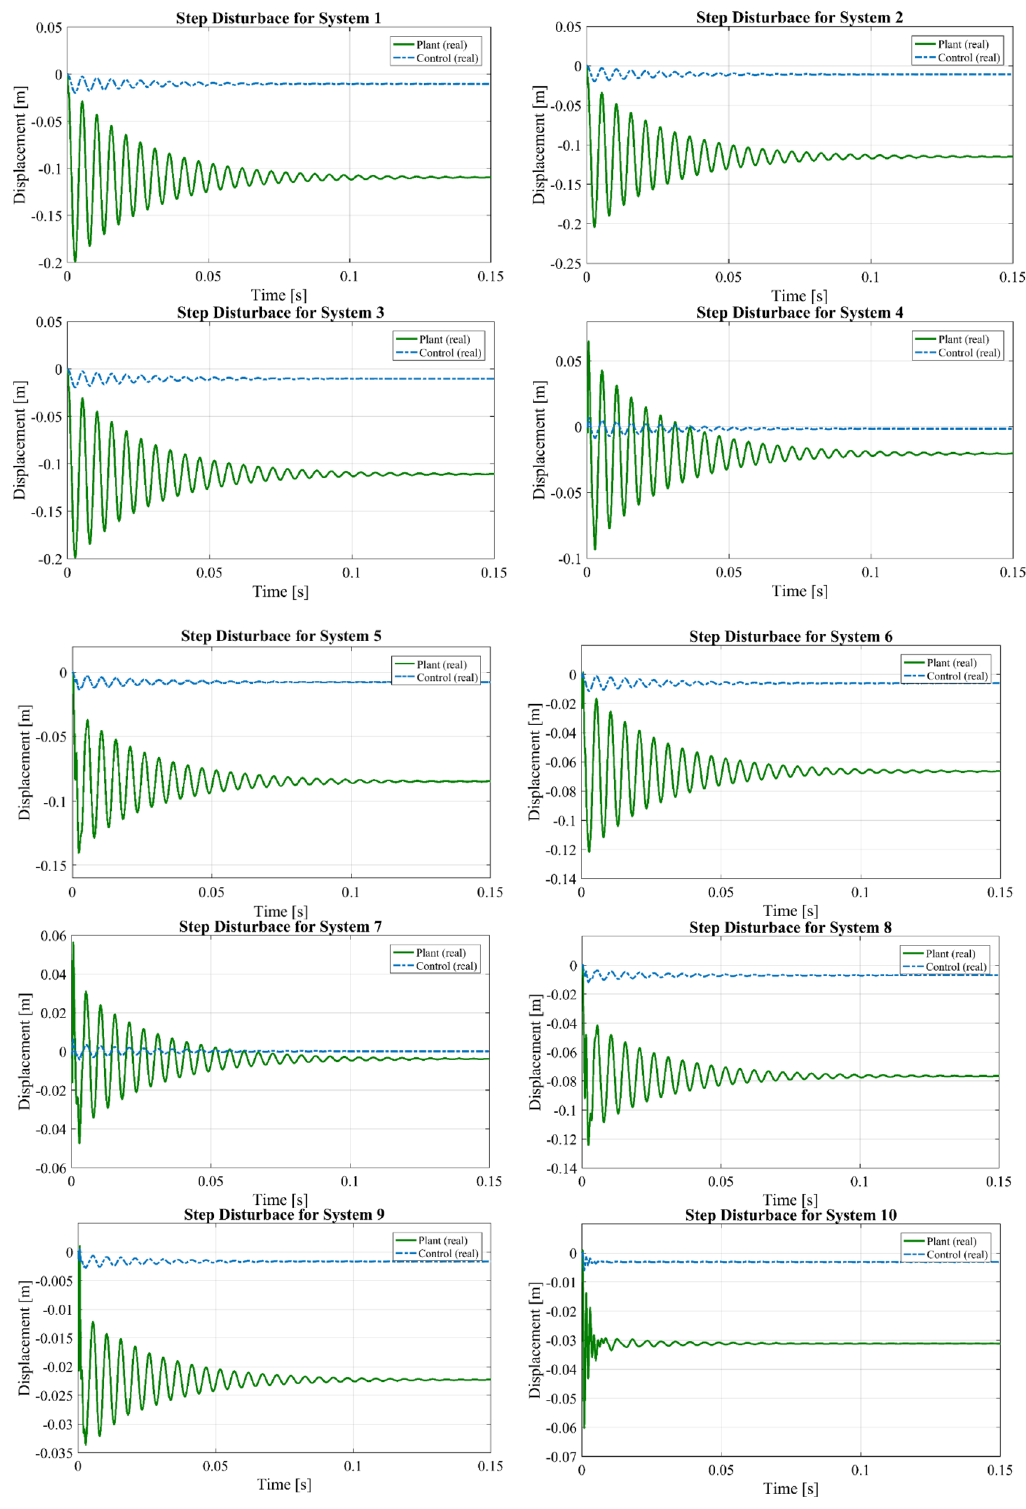
Figure 15. Step input: vertical displacement of the middle point with PID controller for all